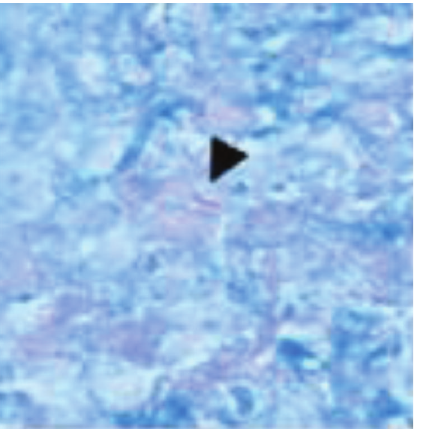
Figure 4: Acid fast bacilli (arrow head) (AFB stain, 100x magnifica-